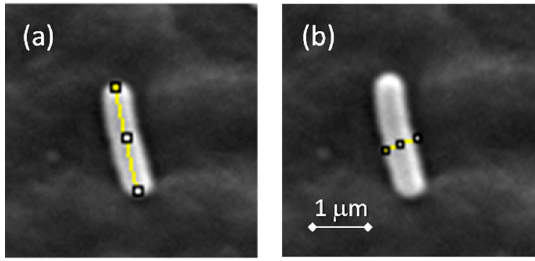
Figure 8. Examples of the measurements of ( a ) length and ( b ) width of a bacterium.